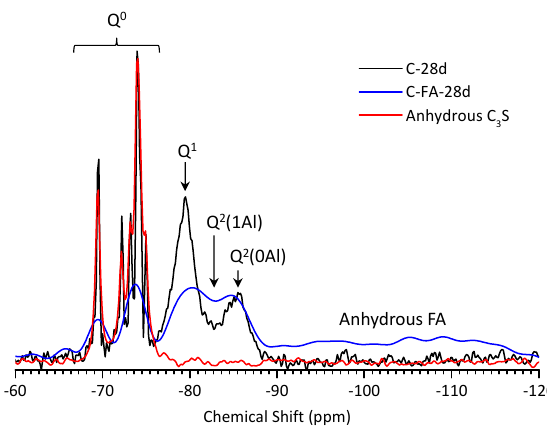
Figure 12. 29 Si MAS NMR spectroscopy of anhydrous C 3 S, C-28d, and C-FA-28d.